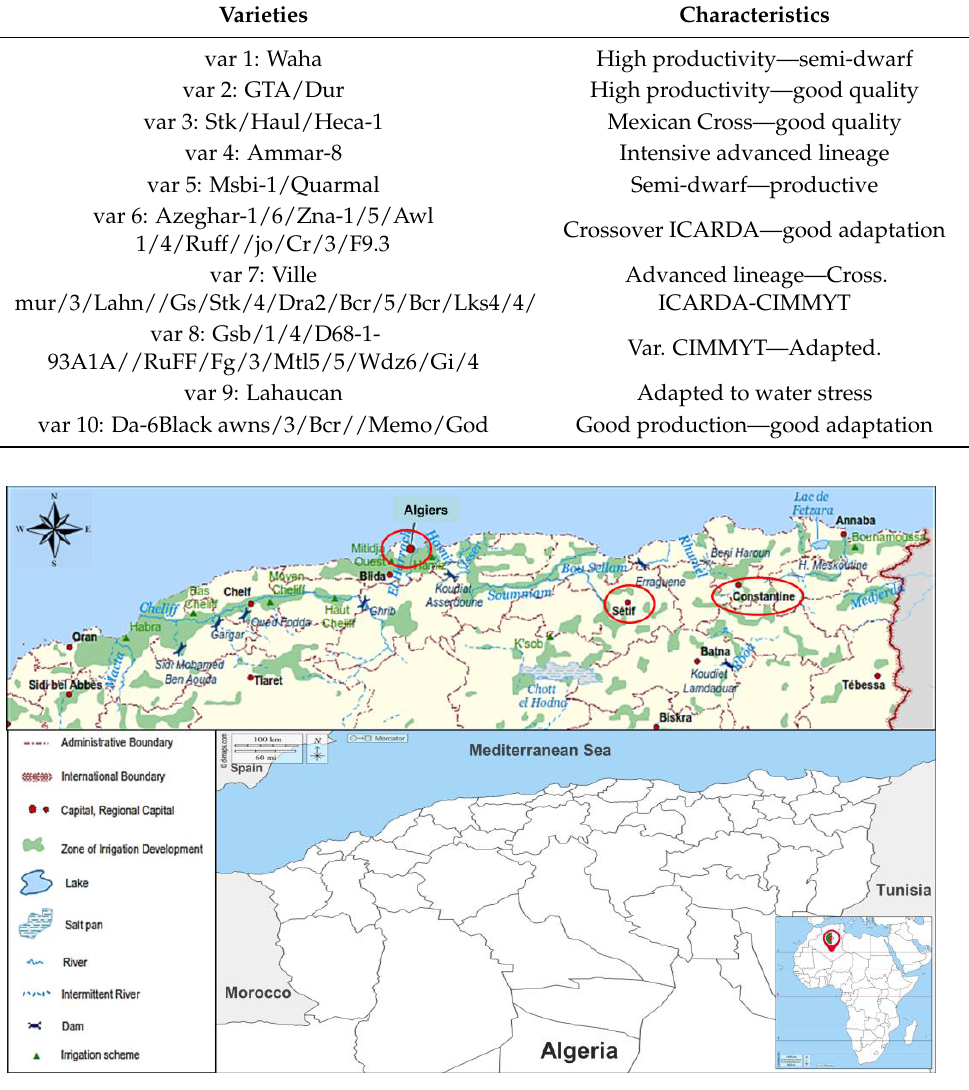
Figure 1. Irrigation characteristics in the studied agroecological zones (red circles) modified from FAO — AQUASTAT [19]. FAO—AQUASTAT